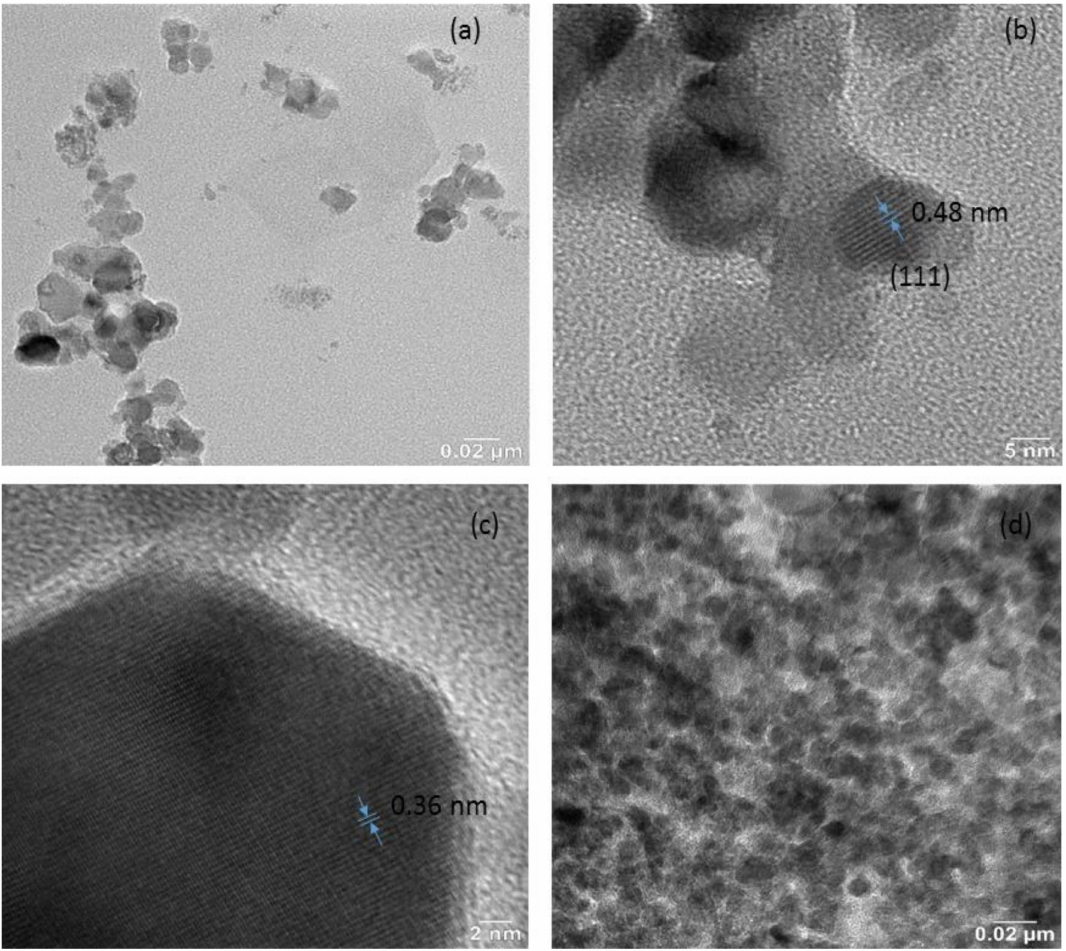
Figure 5. ( a ) TEM study of NiFe 2 O 4 nanoparticles, ( b ) HRTEM study of NiFe 2 O 4 nanoparticles, ( c ) HRTEM study of graphene oxide, and ( d ) TEM study of NiFe 2 O 4 -5wt%RGO-Polypropylene elastomer